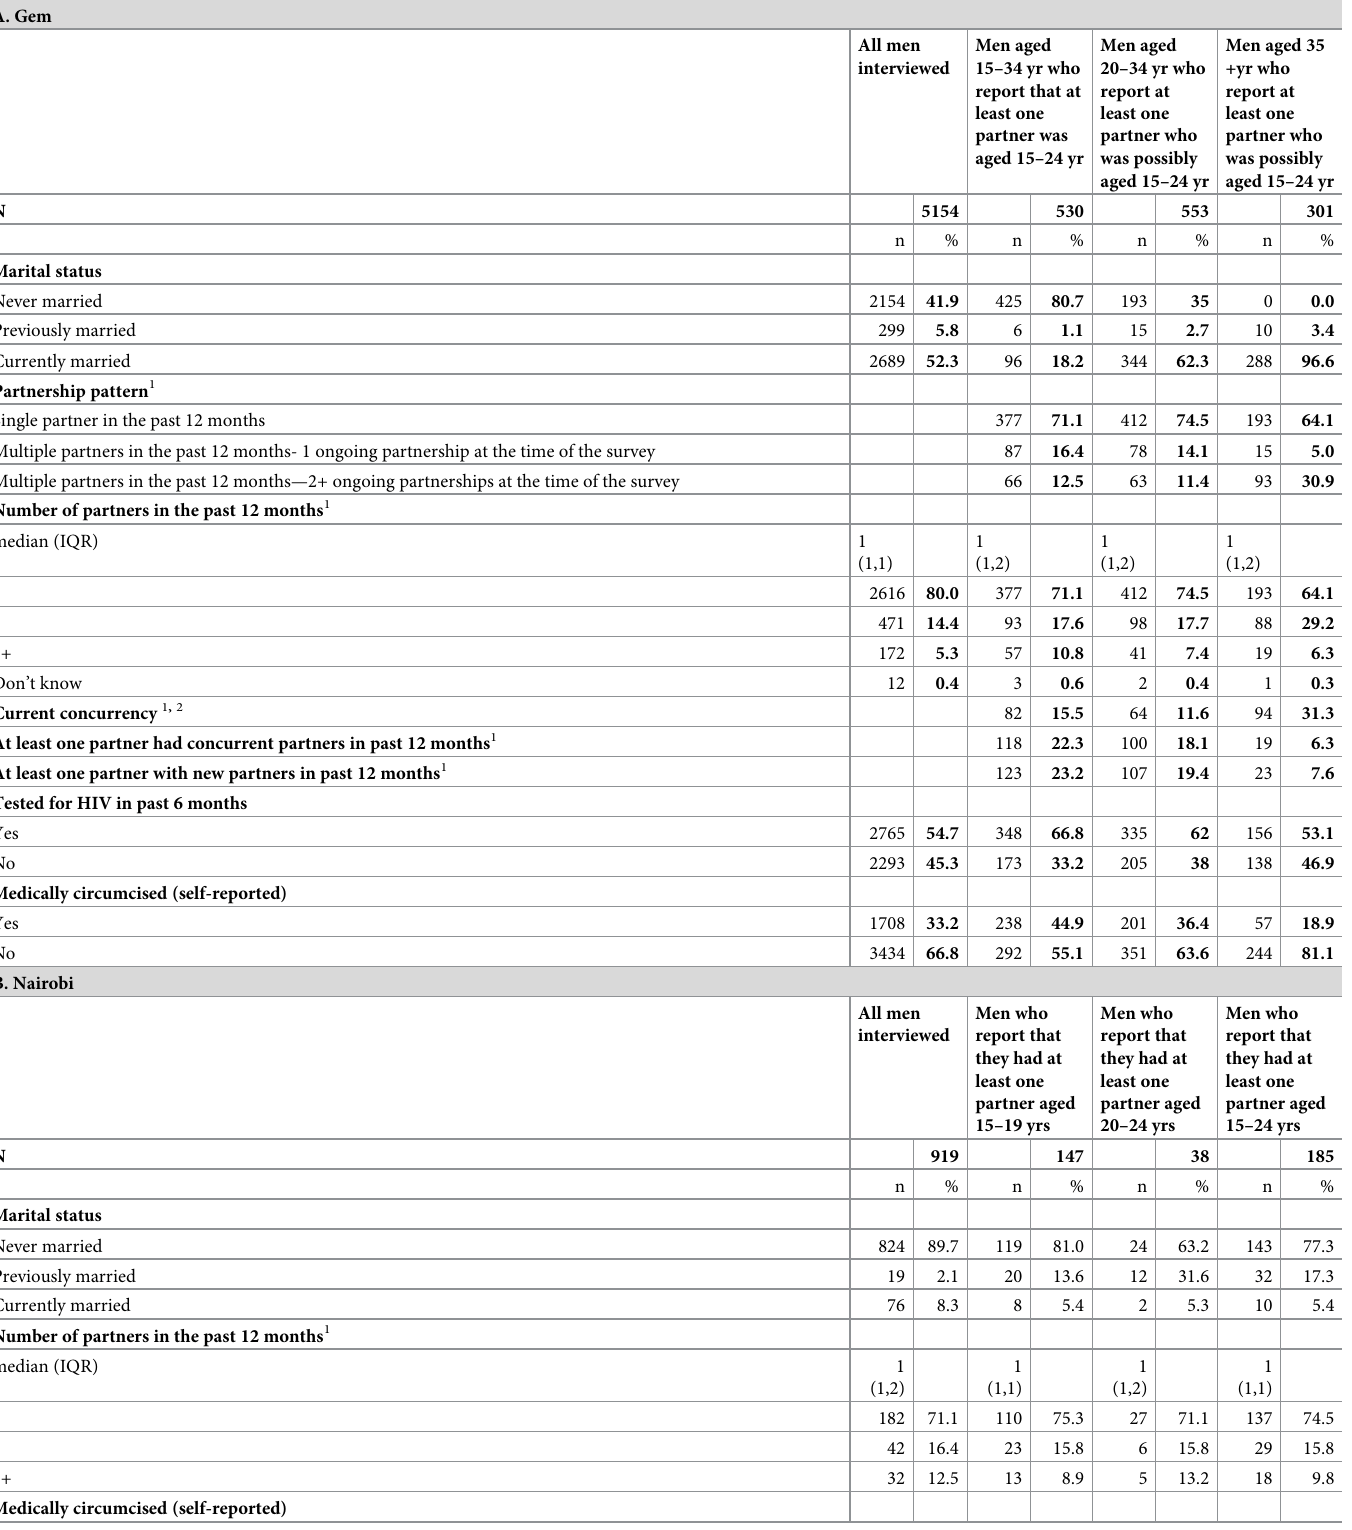
Table 3. Profile of males who report a partner aged 15–24 years in the past 12 months (based on last 3 partners, source: Male interviews). A.